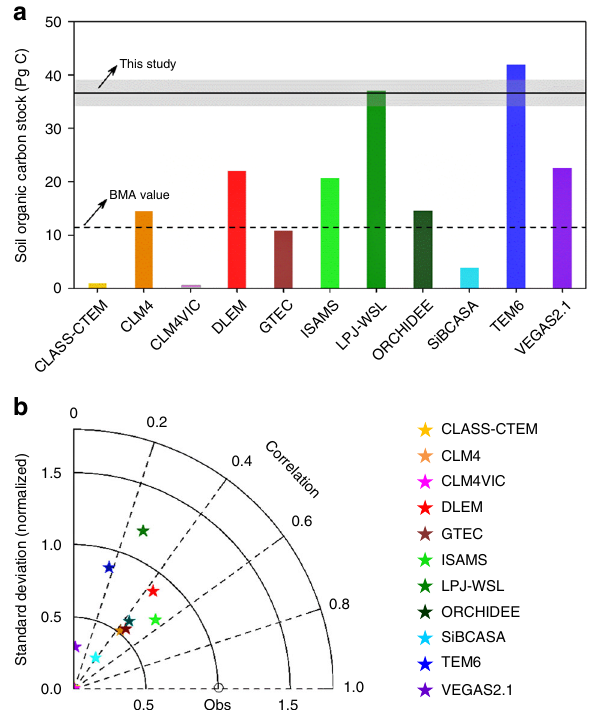
Fig. 4 Comparison of soil carbon stock simulated by 11 ecosystem models with estimates from this study. a Shows total soil organic carbon stock. BMA value represents the weighted ensemble mean of the model outputs based on the Bayesian model averaging method 31 . b is the Taylor diagram which shows correlation coef fi cients between the gridded model simulations and estimates from this study (Obs), and the normalized standard deviation of model simulations. The model simulations originated from the Multi-scale Synthesis and Terrestrial Model